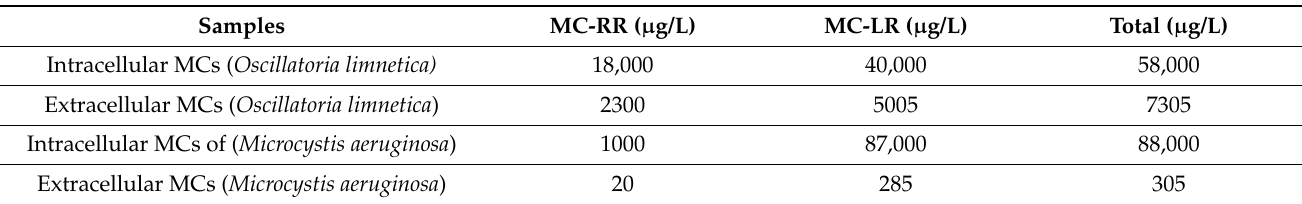
Table 2. Concentrations of intracellular and extracellular microcystins in Microcystis aeruginosa and Oscillatoria limnetica isolated from